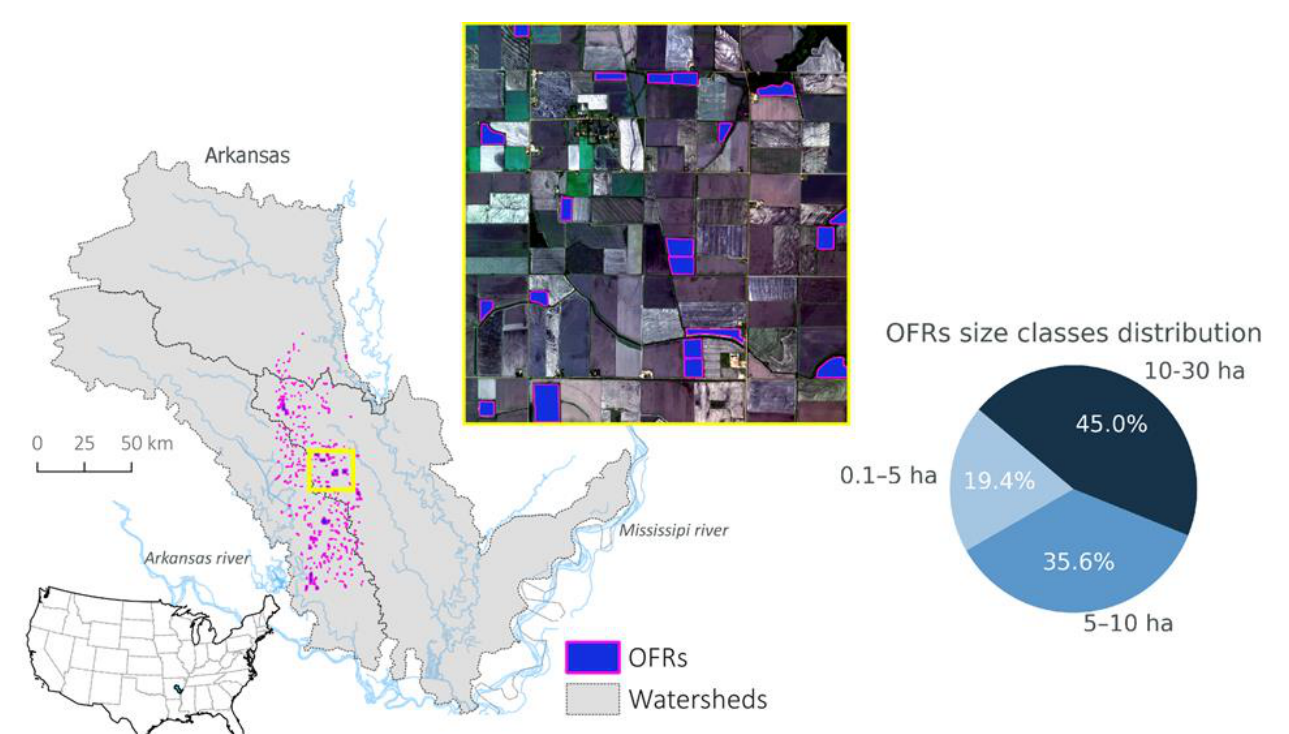
Figure 1. Study region in eastern Arkansas, USA, and the OFRs size distribution. The inset map represents the OFRs shapefile overlaid on SkySat satellite imagery.